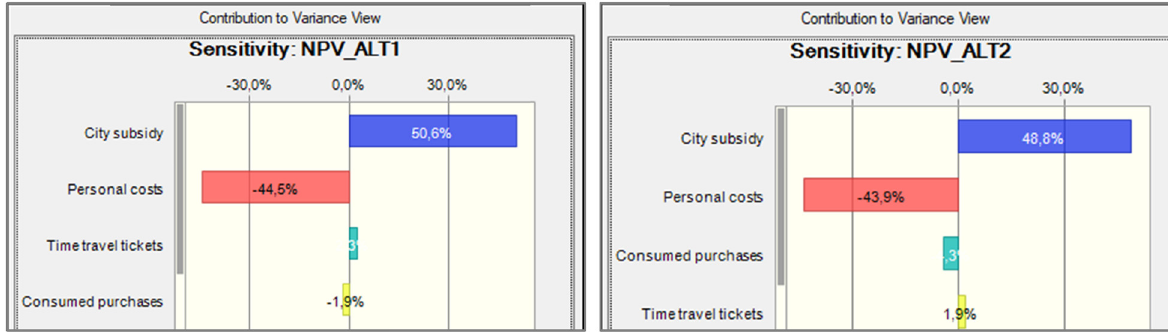
Figure 4: Sensitivity analysis.